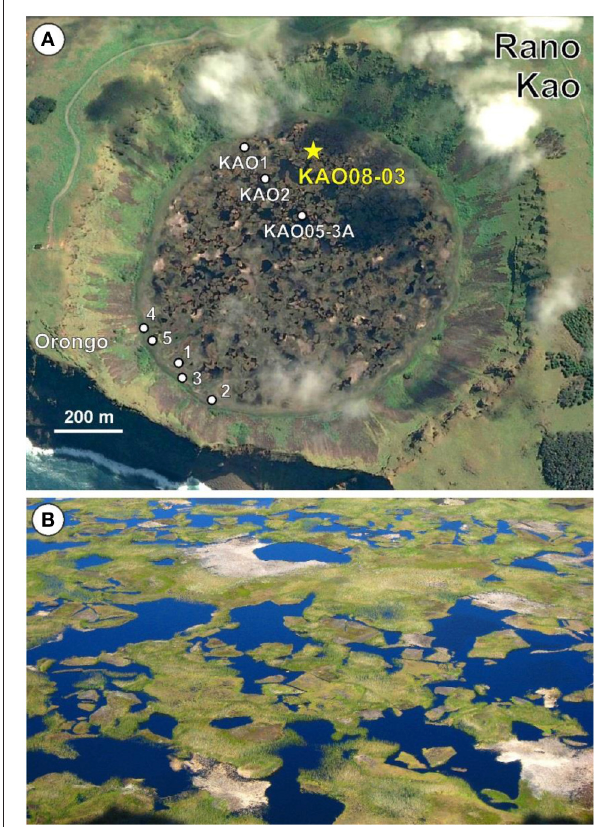
FIGURE 7 | Rano Kao. (A) Google Earth view of Rano Kao indicating the coring sites from previous works (white dots) and the locality described in this paper (yellow star). The ceremonial village of Orongo is also indicated. Redrawn from Rull (2016b). (B) Close up of the floating mats around the center of Lake Kao. Note the sharp and angular nature of most mat/water contacts (Photo: O. Margalef).